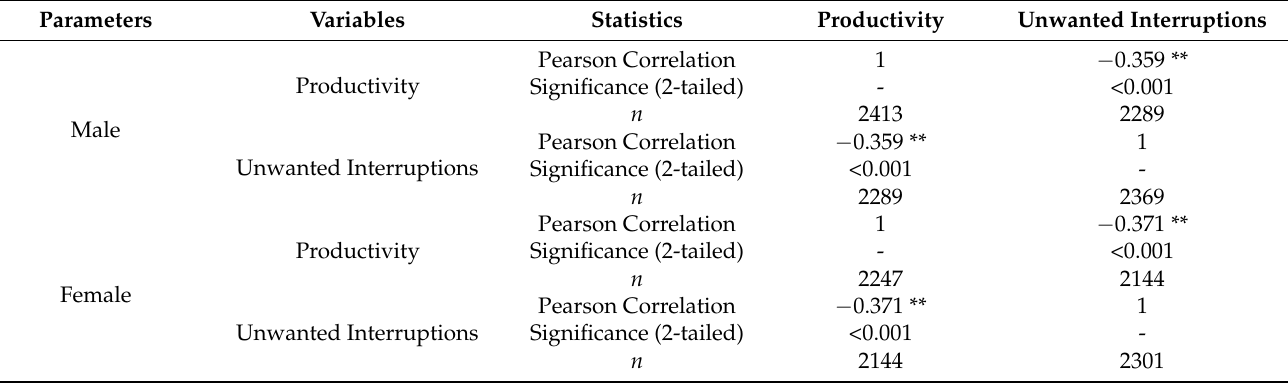
Table 15. Pearson correlation comparing productivity and unwanted interruptions for male and female gender groups. Parameters